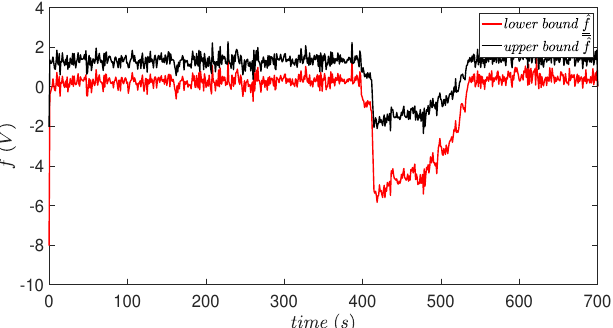
Figure 4. Estimation of the bounds for the input voltage fault.